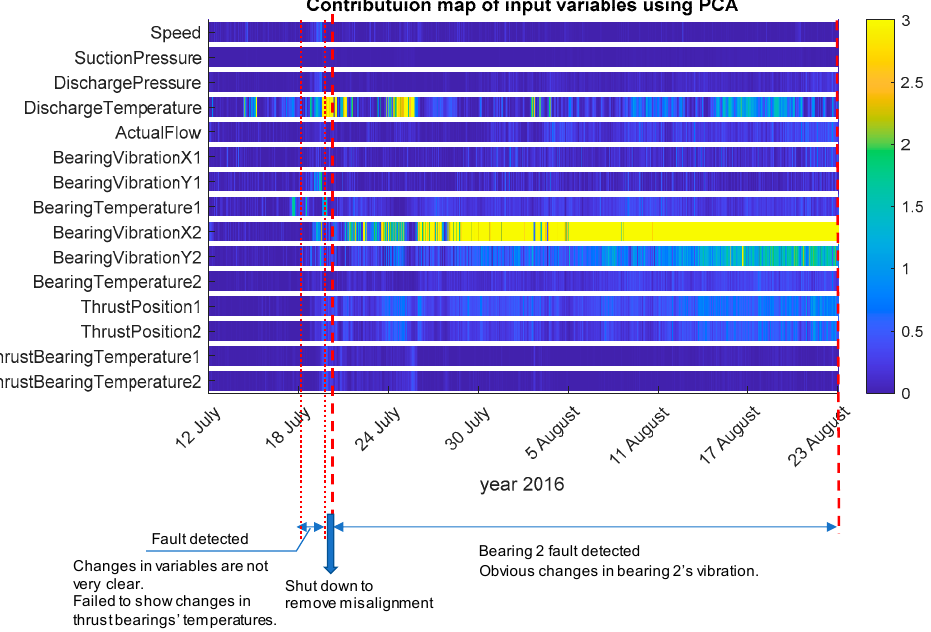
Figure 13. Contribution map by the PCA model from 12 July 2016 to 23 August 2016.